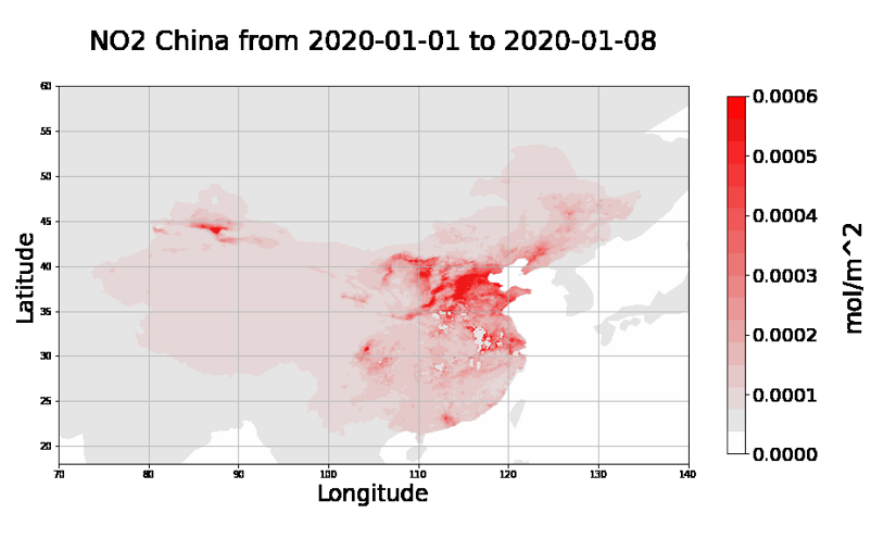
Figure 11. NO 2 concentration in Italy (from 1 to 5 January 2020).